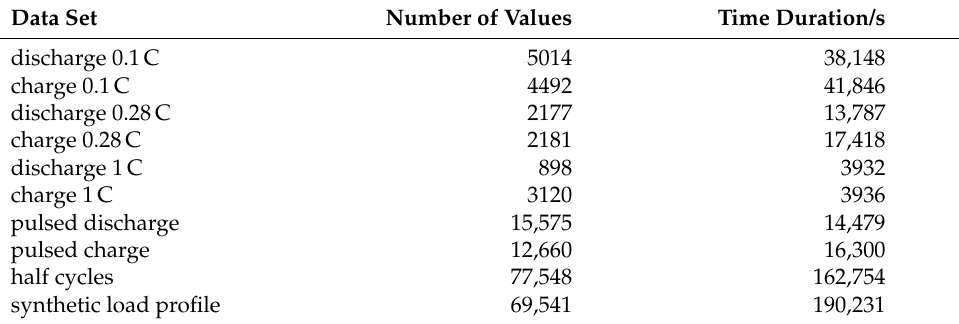
Table 1. Measurement data for training and testing the